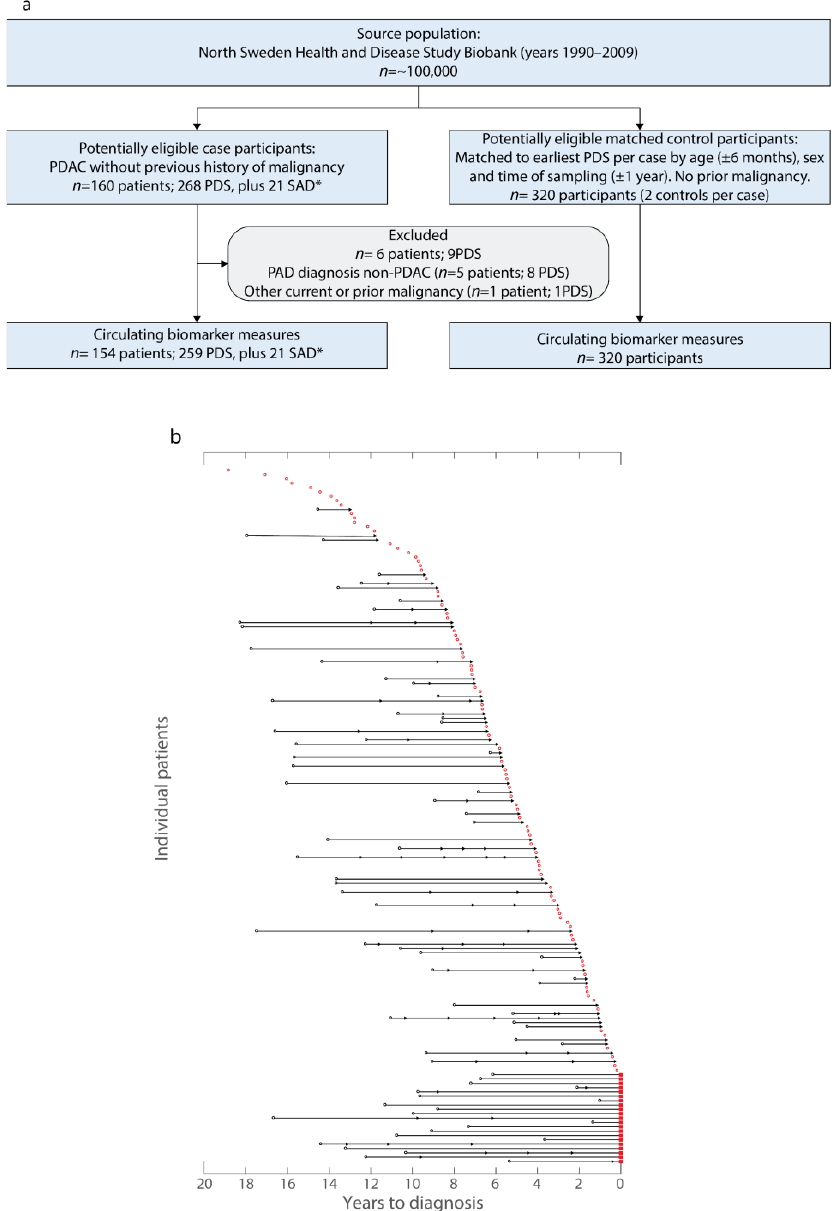
Figure 1. Description of the pre-diagnostic cohort from Northern Sweden Health and Disease Study (NSDHS) and of those patients that also provided samples at diagnosis (SAD) in the Umeå prospective clinical biobanks (UPCB). ( a ) Flowchart of the study and matched control cohorts from the NSHDS cohort showing the inclusion and exclusion criteria (PDS: Pre-diagnostic sample; SAD: Sample at diagnosis collected from the UPCB; * samples collected within 40 days from diagnosis date prior to any surgical or oncological treatment). ( b ) Waterfall plot illustrating relationship between included samples and time of clinical diagnosis. Each future PDAC patient is represented on the y-axis. All unconnected dots represent samples from future PDAC patients that provided only one sample. All connected points are from future PDAC patients that provided multiple samples. The shape of each dot indicates the respective order of samples from each patient (circle, earliest sample; arrowhead, subsequent pre-diagnostic sample(s); square, sample at PDAC diagnosis). Samples in black were those used in both OPLS-DA modelling in the longitudinal analyses and cross-sectional analysis. Samples in red were used for cross-sectional analysis. Patients that provided samples at diagnosis (squares) had all provided samples examined by spaghetti plots.